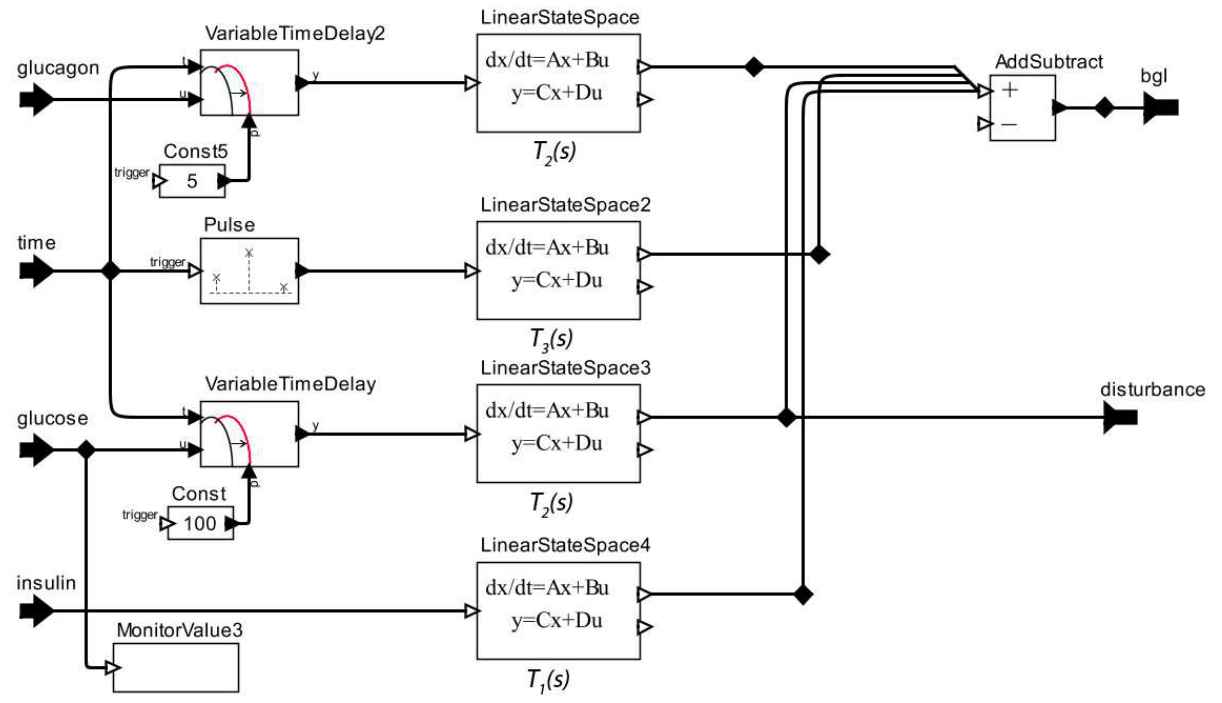
Figure 5. Model of the Effect of Insulin to Control a Patient Glucose